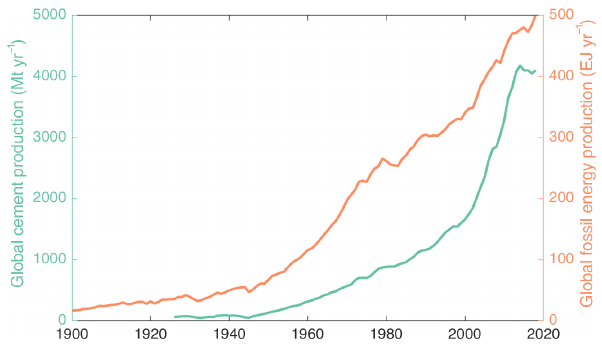
Figure 1. Global cement and fossil energy production to 2018 (Mohr et al., 2015; USGS, 2016, 2018; BP, 2019).